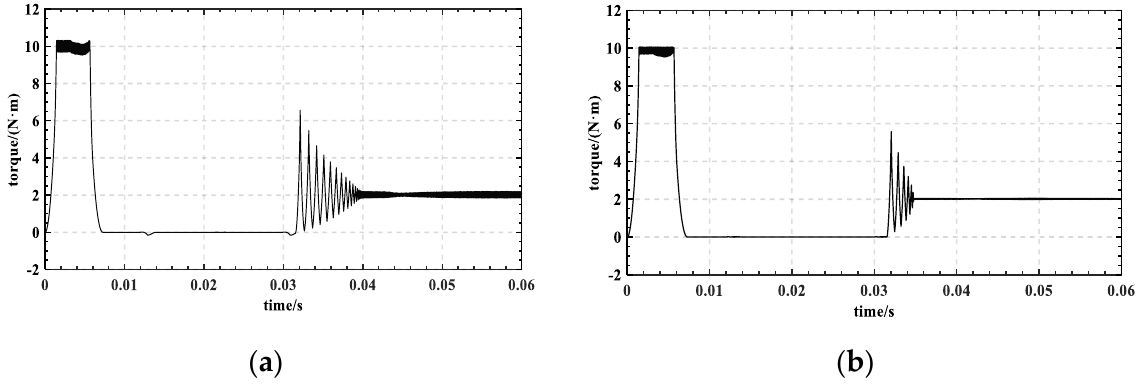
Figure 11. Torque comparison with 2 N load: ( a ) torque of PID control system and ( b ) torque of FNN